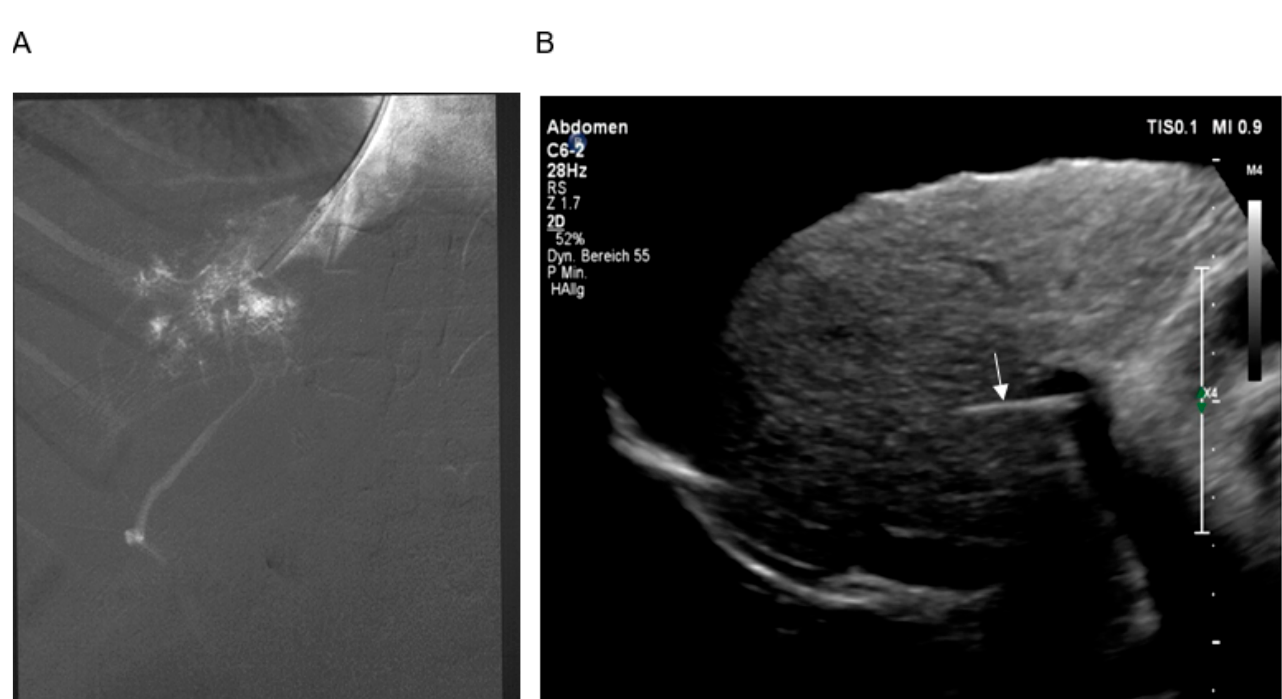
Figure 2. ( A ) Hand-injection of contrast into the parenchyma of the liver showing retrograde filling of a portal branch. ( B ) Sonographic guidance of the puncture. The location of the needle (arrow) and the portal vein is demonstrated.